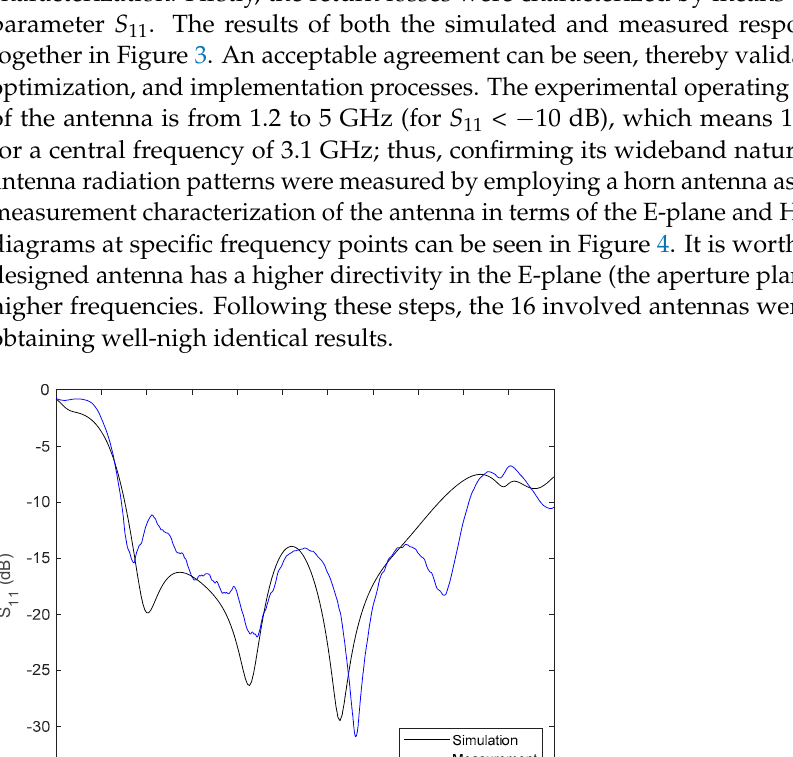
Figure 4. Measured antenna radiation pattern at specific frequency points: ( a ) E-plane; ( b ) H-plane. 2.1.2. Antenna Time Domain Analysis The signals used in medical imaging systems are usually broadband, i.e., they in- volve remarkably short pulses in time covering a considerably broad frequency spectrum. Since the pulses are narrow, they are greatly affected by dispersion. As a result, the in- coming pulse at the antenna will never be the same as the outgoing pulse. For this reason, a time domain analysis of the transmitted pulses was completed, in order to predict the distortion inherent to the system. To do that, the transfer function for a system in which a pulse is transmitted and received by the same single antenna (like the system shown here) can be measured and characterized by an equivalent system in which there is a direct transmission between two identical antennas (i.e., the receiving antenna is exactly the same as the transmitting an- tenna). This assumption considerably simplifies the analysis and measurement of the transfer function of the original system, and it will be therefore taken in this section. Please note that this assumption is taken for characterization purposes only. This scheme uses two identical antennas vertically oriented in a face-to-face manner and separated by 40 cm, distance sufficient to ensure far field transmission. This way, the system’s transfer function reduces to the S 21 parameter. Therefore, the two antennas were located inside an anechoic chamber and the S 21 parameter was measured using the VNA, with one antenna